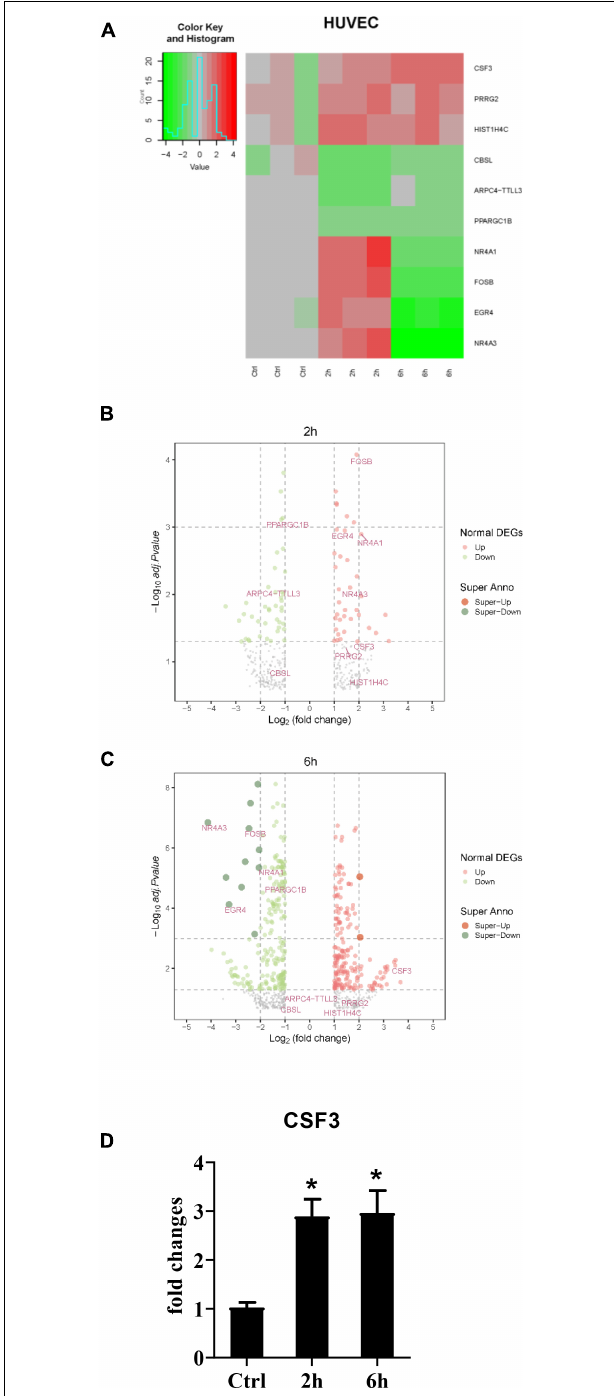
FIGURE 3 | RNA-seq data of HUVECs after stimulation with conidia of A. fumigatus . HUVECs were seeded in a six-well plate (2 × 10 6 cells per well) overnight before the conidia of A. fumigatus were added to the wells at a cell:spore ratio of 1:2. The cell lysates were harvested 2 and 6 h post-stimulation and sent for RNA sequencing. The heat-map (A) and volcano plots of 2 h (B) and 6 h (C) are shown. (D) The RNA expression of colony-stimulating factor 3 ( CSF3 ) was analyzed by quantitative polymerase chain reaction (qPCR). * p <